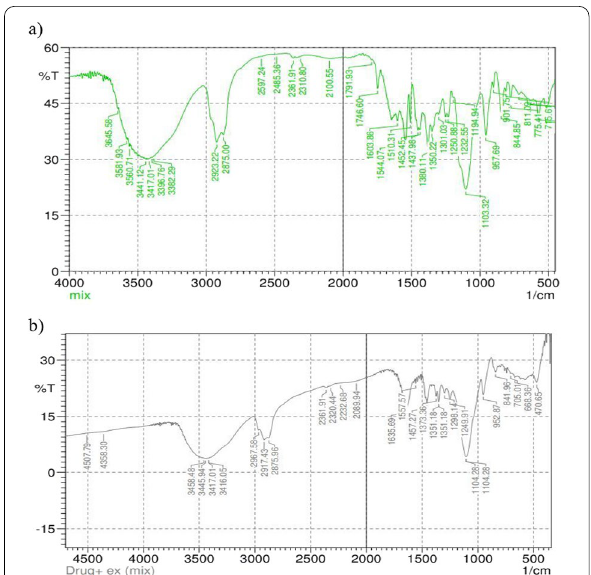
Fig. 4 a Fourier transform infrared spectroscopy report of solid dispersion. b Fourier transform infrared spectroscopy report of drug– excipient mixture. The peak positions of cilnidipine are depicted in wave